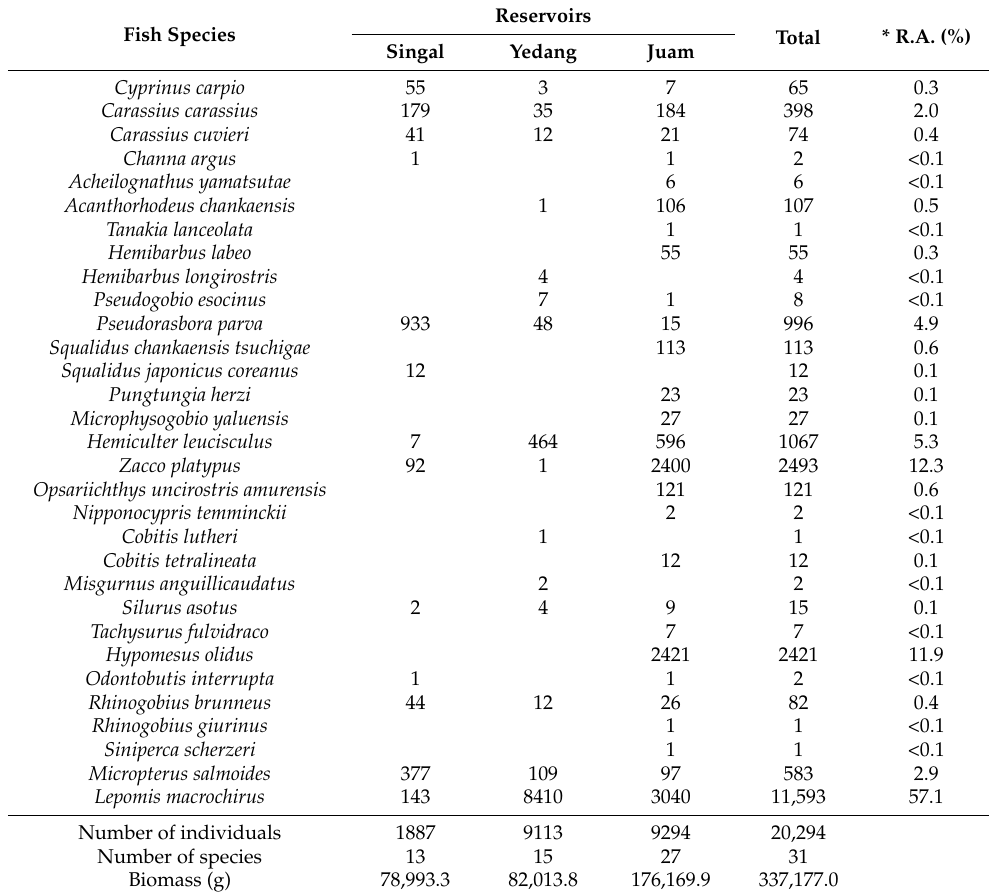
Table 1. The list and the number of fish individuals collected from the three reservoirs. These species were collected with a kick net, cast net, gill net, and fyke